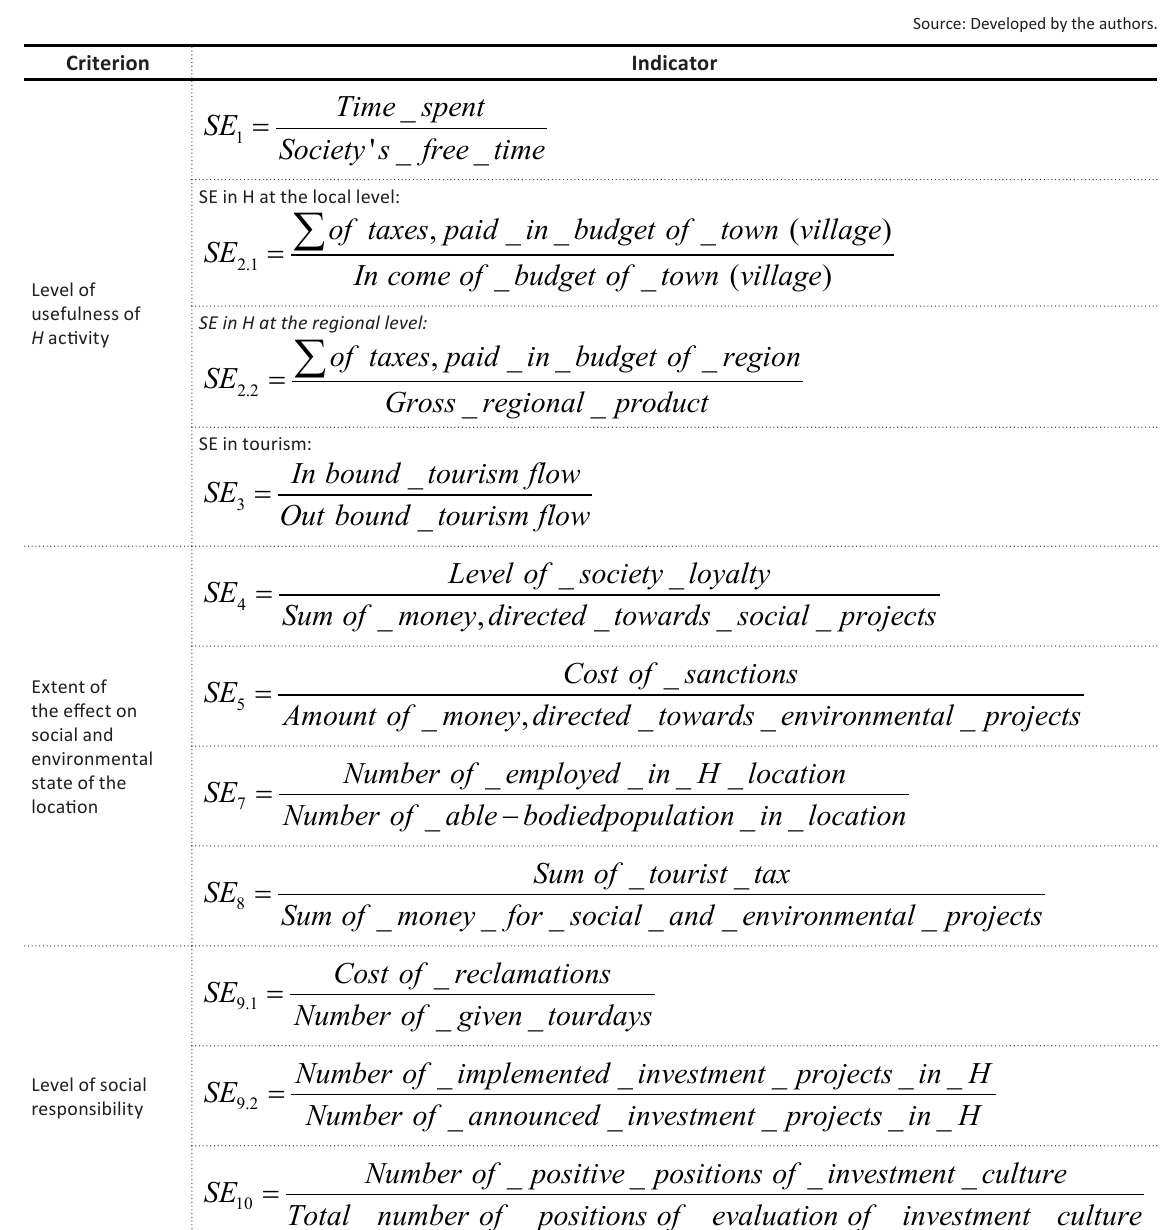
Source: Developed by the authors.